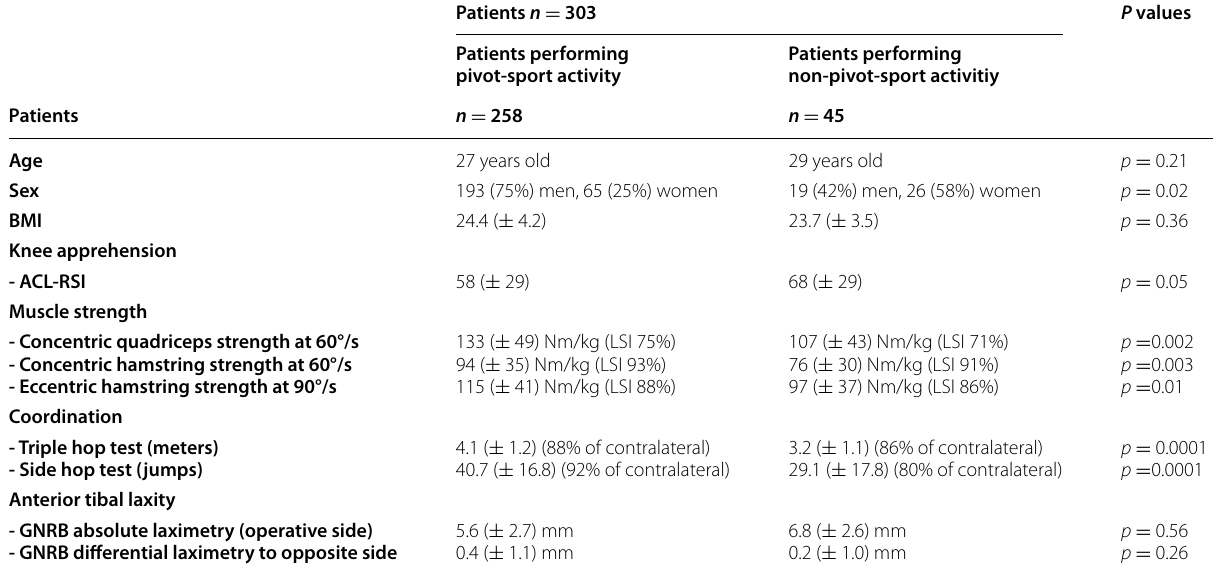
BMI Body mass index, ACL-RSI Anterior cruciate ligament return to sport after injury, LSI Limb symetry index Table 4 ACL-RSI < 40 versus > 65 after ACL reconstruction